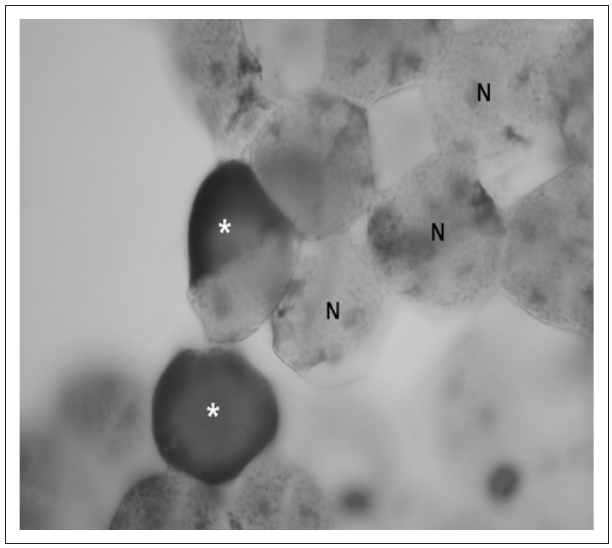
FIGURE 7: Methyl-green and pyronin